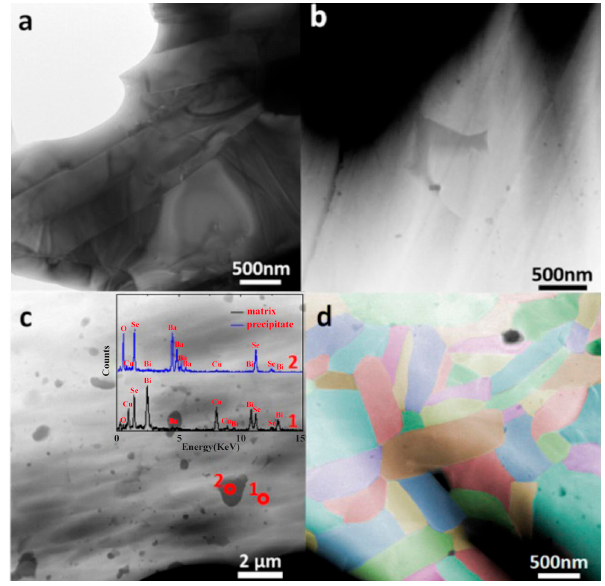
Figure 8. Low-magnification micrographs of ( a ) BiCuSeO in TEM mode; ( b ) Bi 0.95 Ba 0.05 CuSeO in STEM mode and ( c ) Bi 0.875 Ba 0.125 CuSeO in STEM mode; ( d ) Grains of Bi 0.875 Ba 0.125 CuSeO. Reproduced with permission from Reference [65]. Copyright 2016, Elsevier Science.